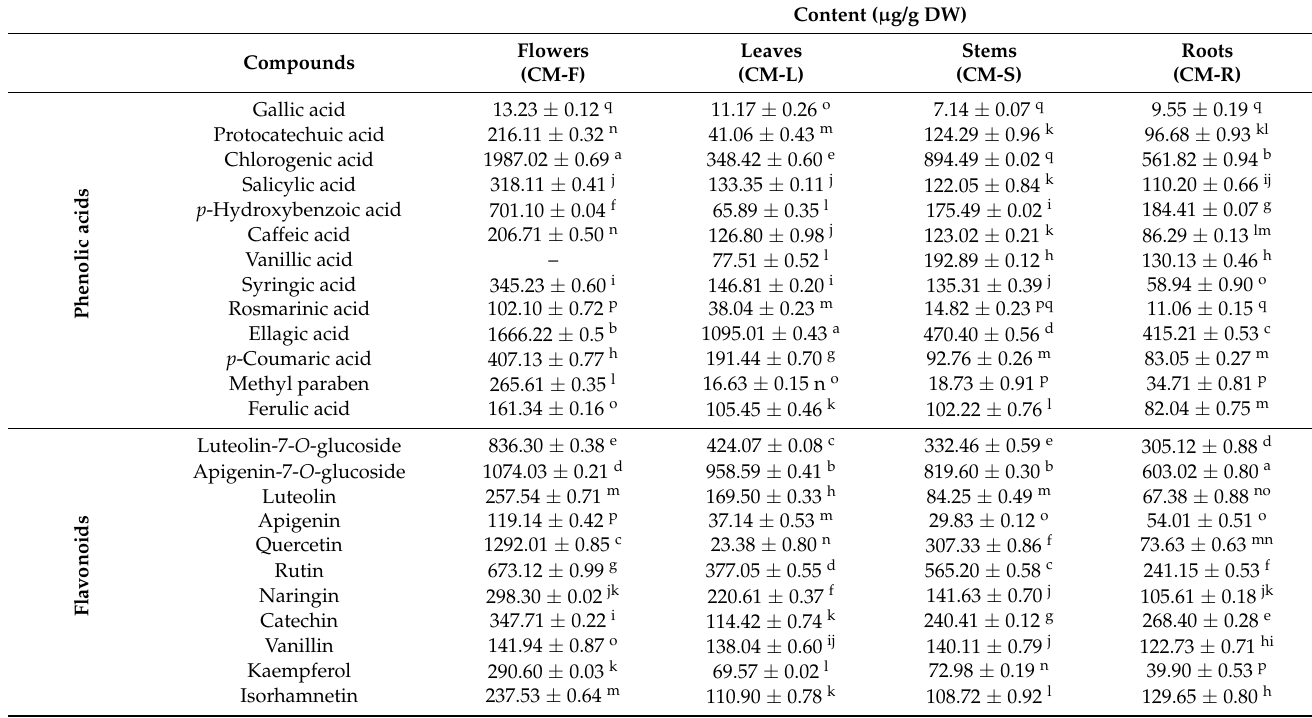
Table 1. Quantification of phenolic compounds in extracts of Cladanthus mixtus obtained by